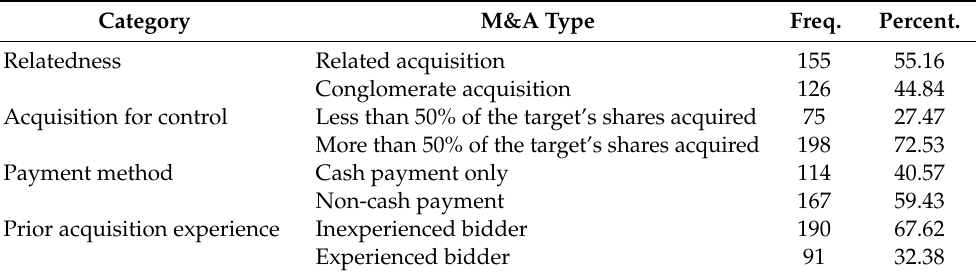
Table 3. Breakdown of the sample by